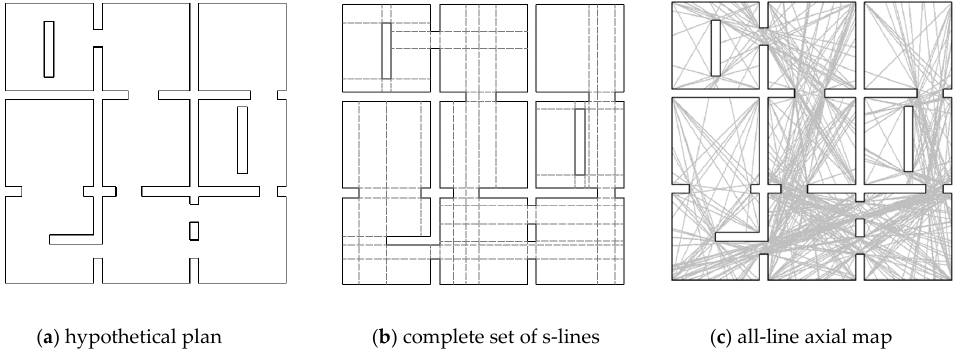
Figure 1. Hypothetical plan. ( a ) Hypothetical floor plan; ( b ) Description; ( c ) All-line axial map.